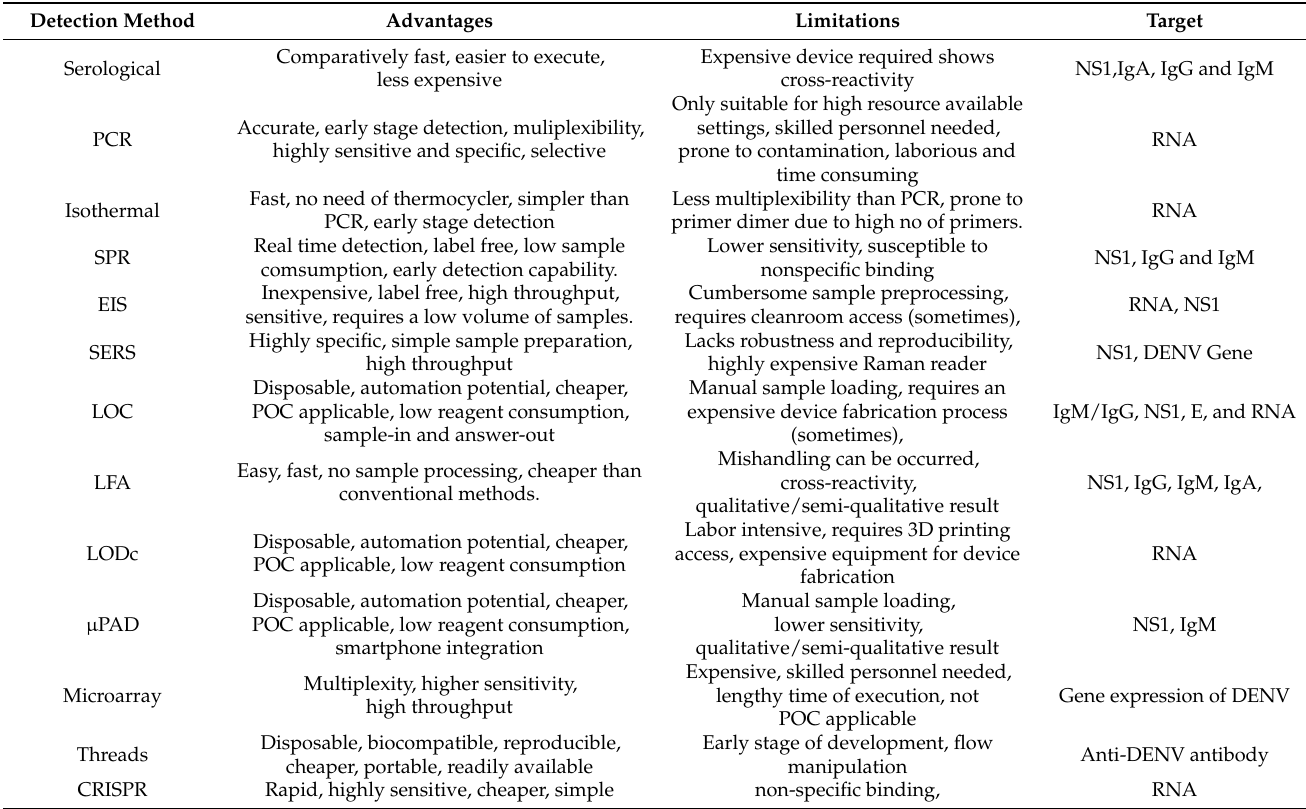
Table 1. Summary of conventional and POC detection methods with their advantages and limitations. Detection